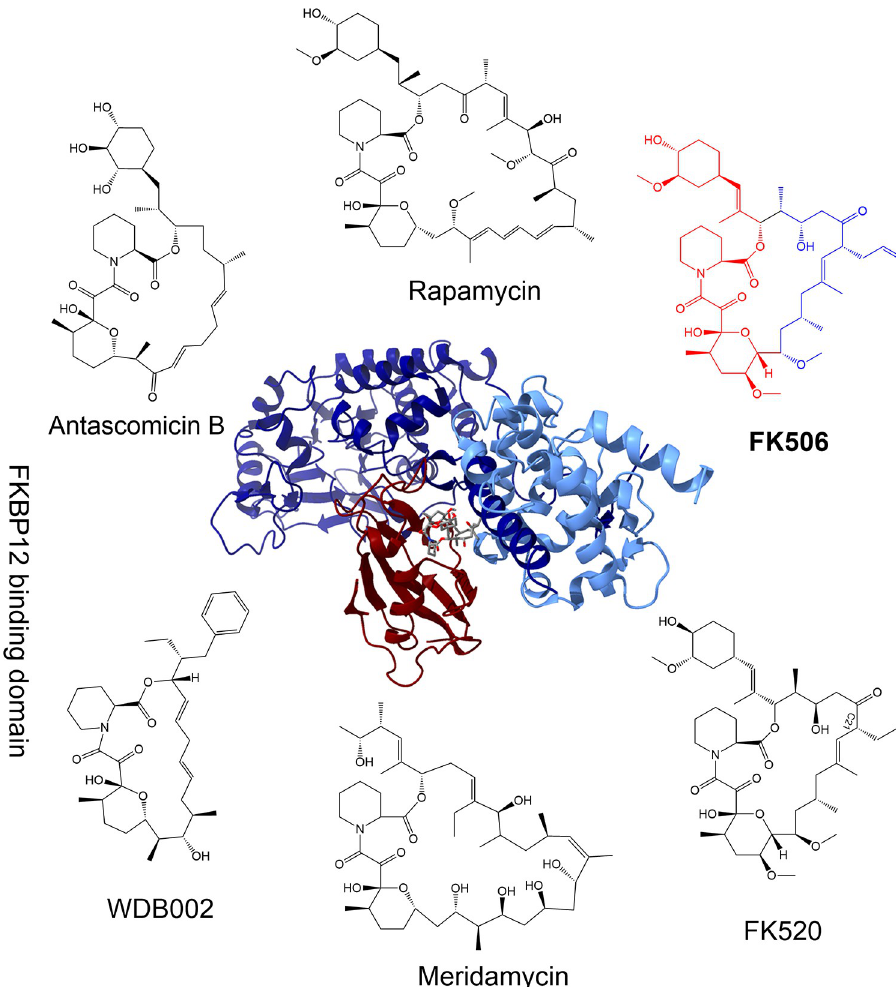
Fig 1. Chemical structures of FKBP12 ligands and crystal structure of FKBP12-FK506 inhibiting target calcineurin. Chemical structures include rapamycin, FK506, FK520, meridamycin, WDB002, and antascomicin B. FK506 chemical structure is shown with FKBP12 binding domain highlighted in red and the calcineurin binding domain highlighted in blue. In the center is the crystal structure of Cryptococcus neoformans calcineurin and FKBP12 bound to natural product FK506 (Calcineurin A subunit colored dark blue, calcineurin B subunit colored light blue, FKBP12 colored dark red, and FK506 colored by atom). Crystal structure adapted from “Harnessing calcineurin- FK506-FKBP12 crystal structures from invasive fungal pathogens to develop antifungal agents” (PDB 6TZ8) [3]. The original figure was published under CC BY 4.0 giving freedom to share and adapt figures from the source listed above.